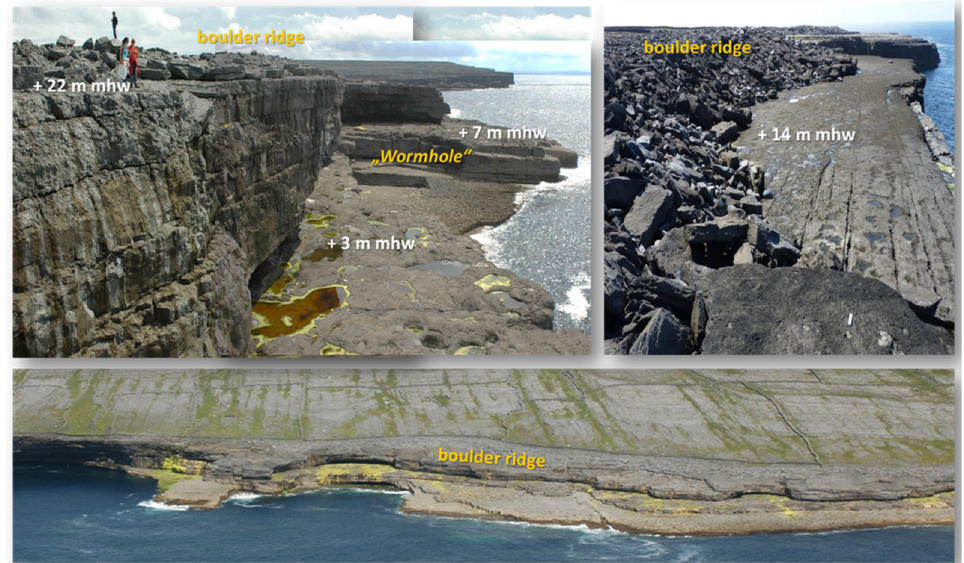
Figure 3. Low and intermediate rock platforms of the Aran Islands usually are bare of sediments (aspects from Inishmore’s south coast).